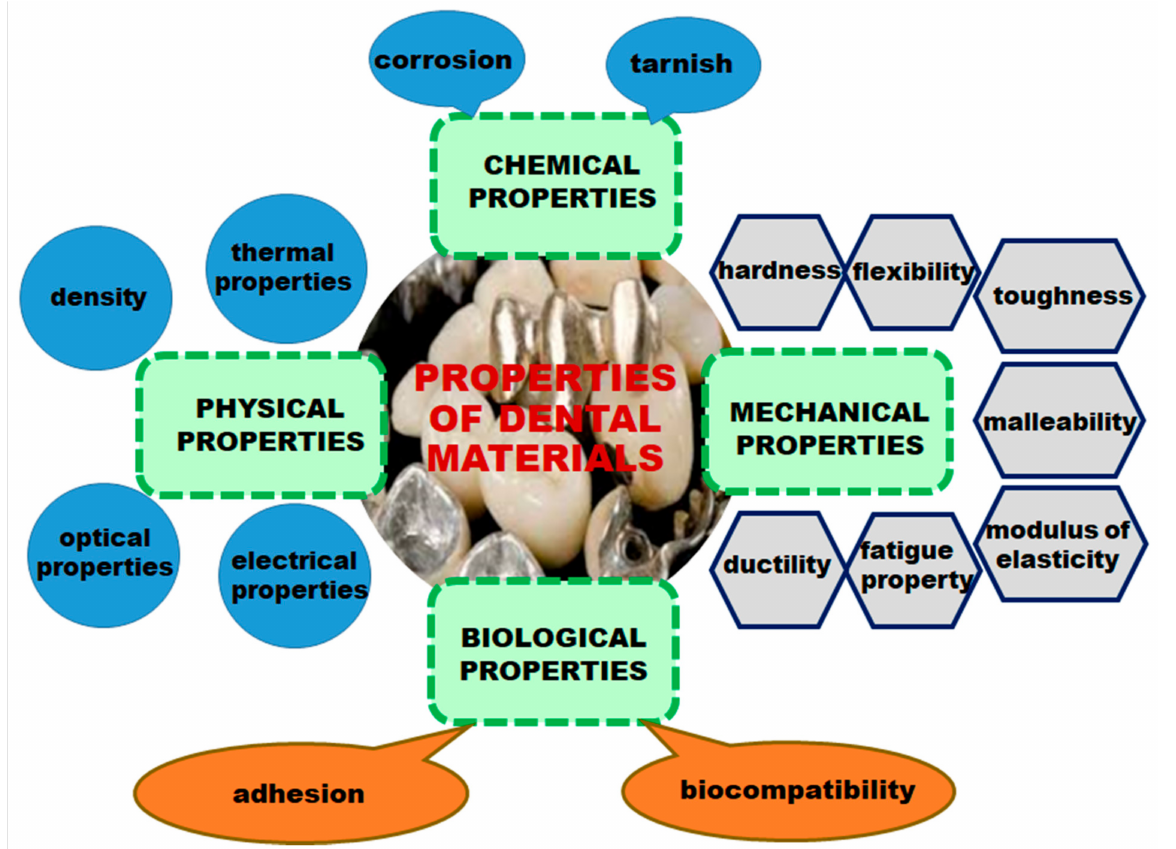
Figure 1. Properties of dental